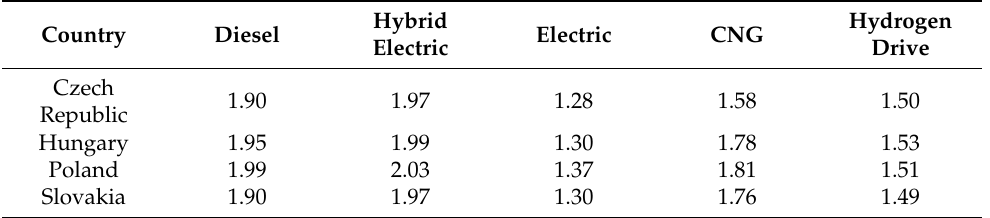
Table 13. Cost of a vehicle-kilometer of mega buses (18 m) with different drive types in the V4 countries for the entire period of use of the vehicle, if subsidized ( € ). Country